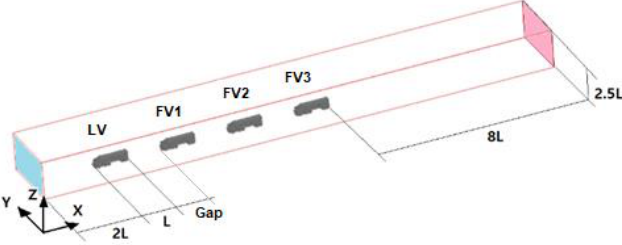
Figure 2. Numerical domain with the model heavy-duty vehicles platooning.